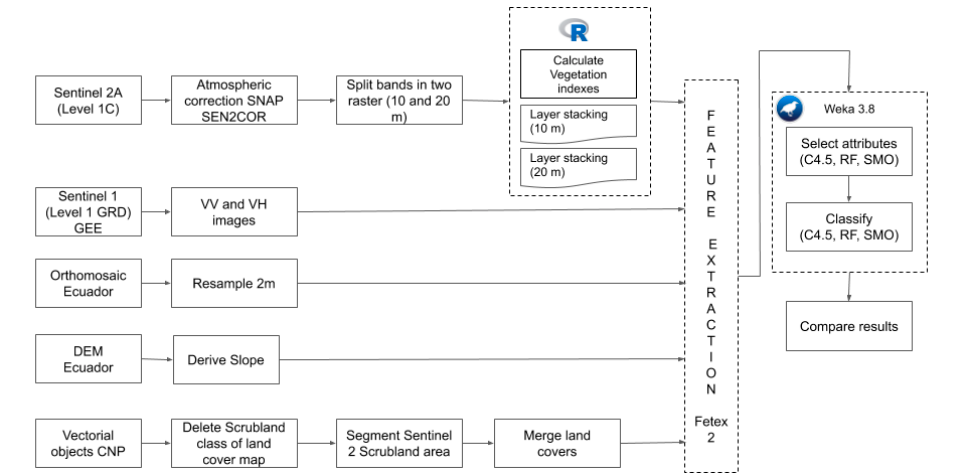
Figure 2. Workflow Characterization